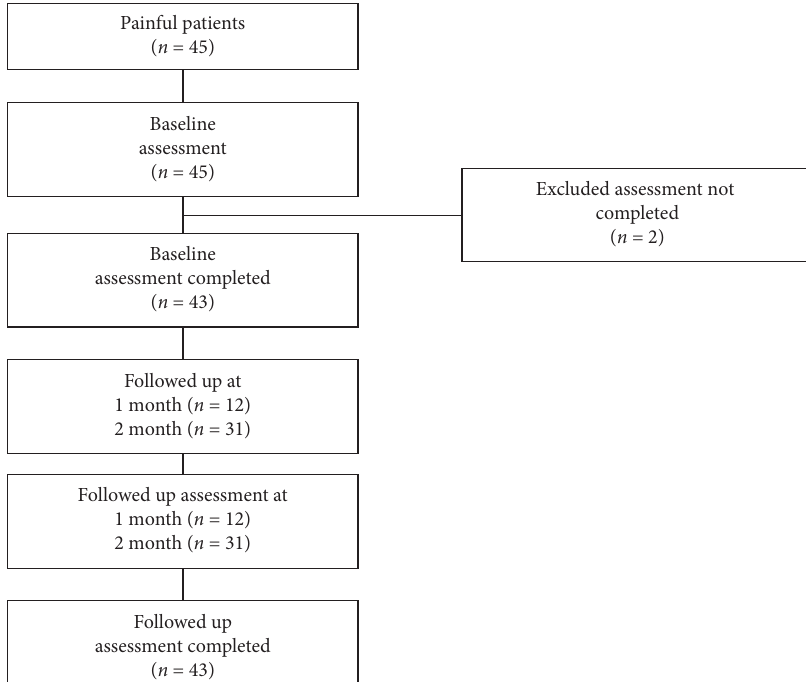
Figure 1: Progression of participants through the trial including losses to